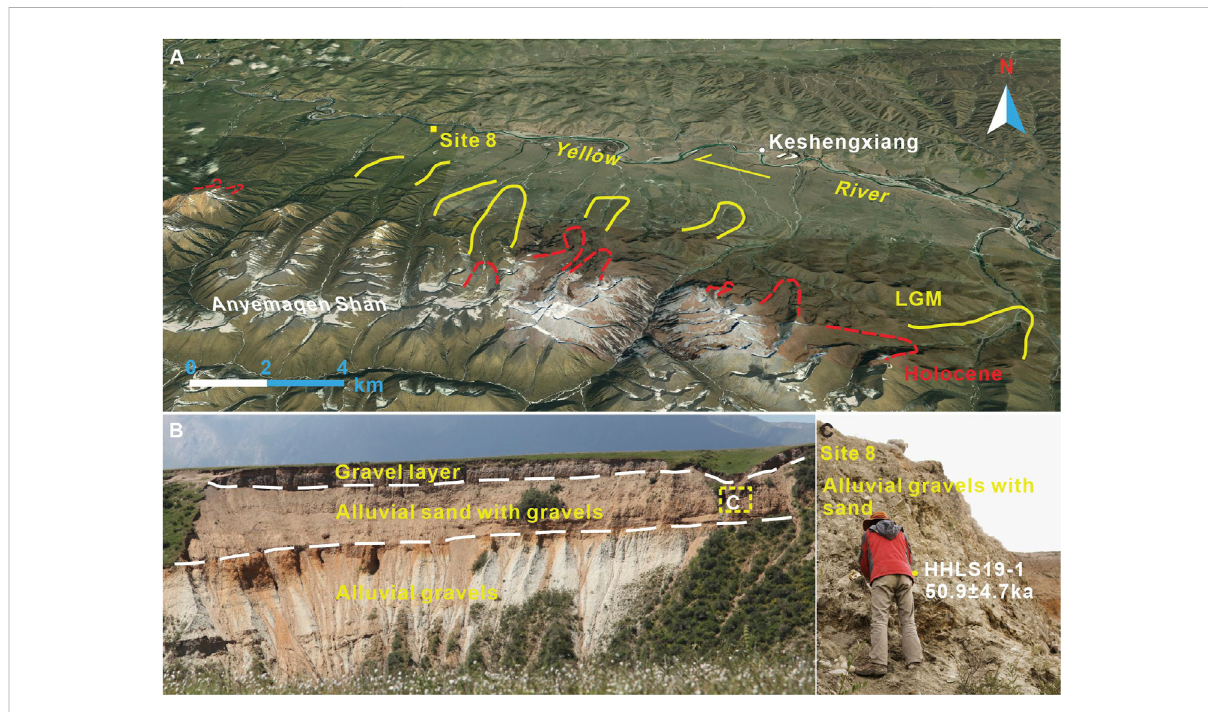
FIGURE 6 (A) Google Earth image showing the distribution of two periods of moraine ridges on the eastern side of the Anyemaqen Shan near Keshengxiang. (B) Photograph showing the sedimentary properties of sediments covering T5. (C) Photograph showing the sedimentary properties and OSL ages at site